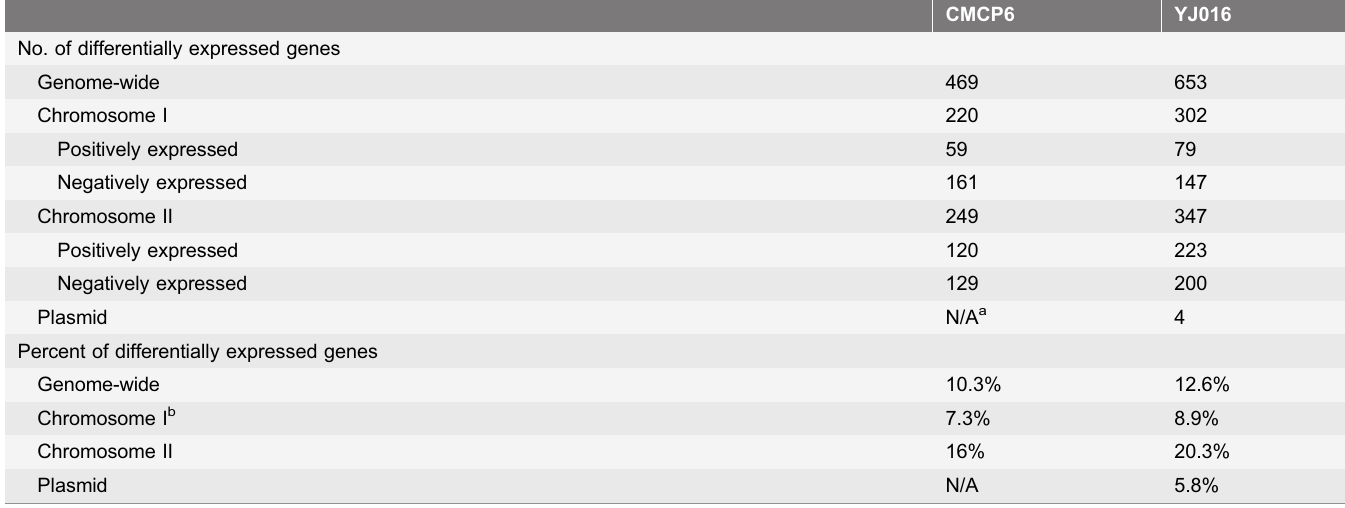
Table 1. Summary of differentially expressed genes (p , 0.0001).